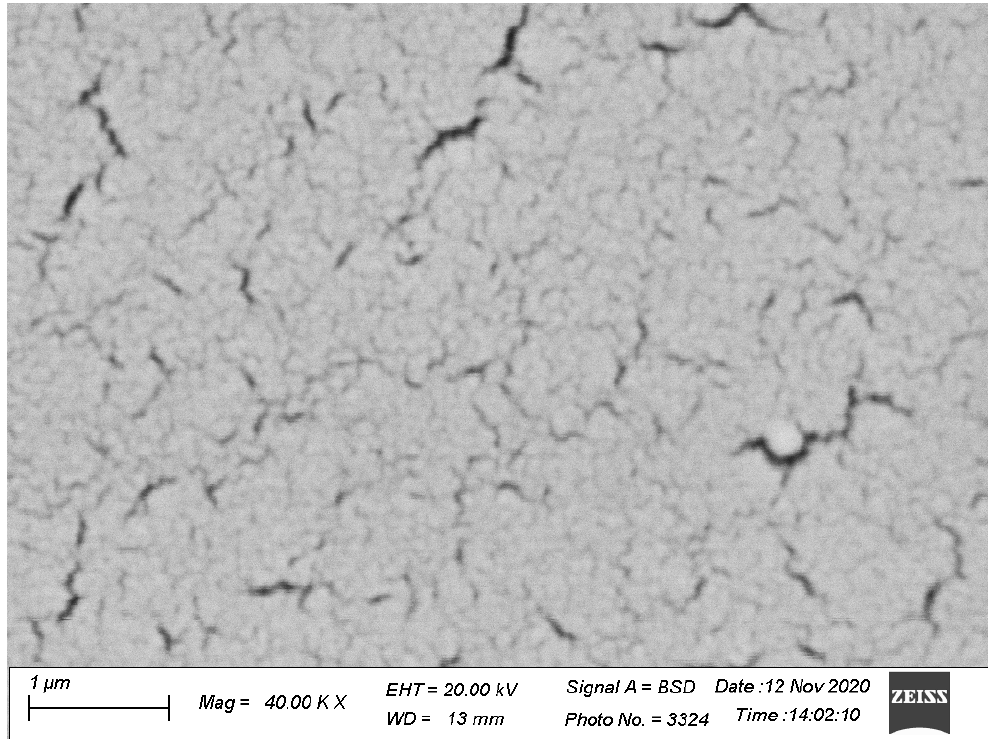
Figure 1. SEM image of the SnO 2 − δ film deposited on glass substrates by reactive magnetron sputtering of tin in the argon–oxygen atmosphere (with oxygen content of about 1 vol %) with the following annealing in air at 450 °C.